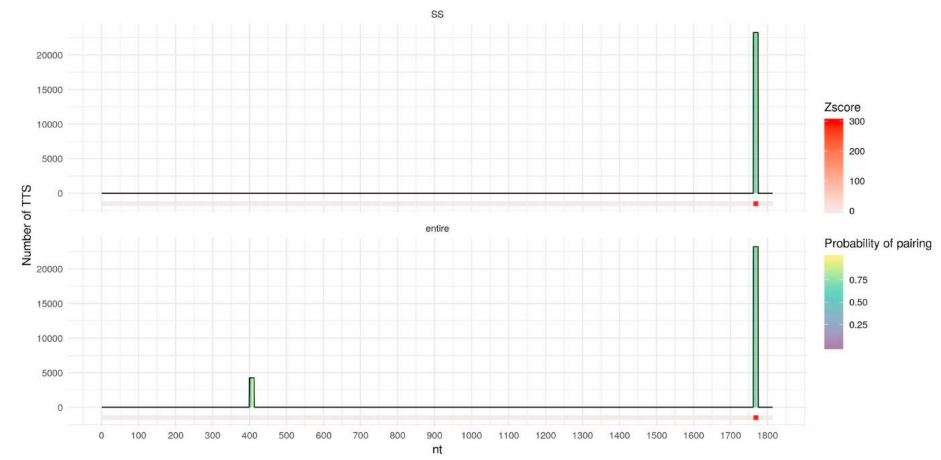
Figure 6. DNA binding domains (DBDs) of the entire DACOR1 (bottom) and of single-stranded fragments of DACOR1 (top), predicted by TDF with DACOR1 best parameters (l10e20g70). The horizontal axis represents DACOR1 in length, columns represent DBDs with height corresponding to the number of DNA peaks (Triplex target sites, TTS) with predicted triplexes for the particular DBD. DBDs columns are filled with color by the probability of pairing for each nucleotide predicted by RNAplfold. DBDs in the DACOR1 sequence are colored by z-score for a particular DBD calculated by TDF based on 10,000 random samplings from the human genome; z-score = 0 corresponds to no DBDs